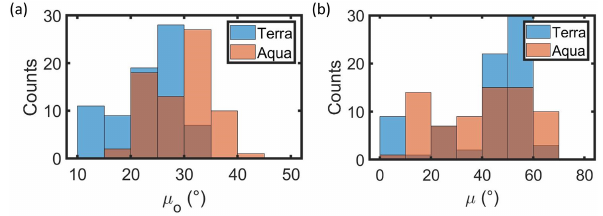
Figure 5. Histograms of (a) solar zenith angle ( µ o ) and (b) sensor zenith angle ( µ ) for MODIS retrievals co-located with in situ data for (cid:49)T less than